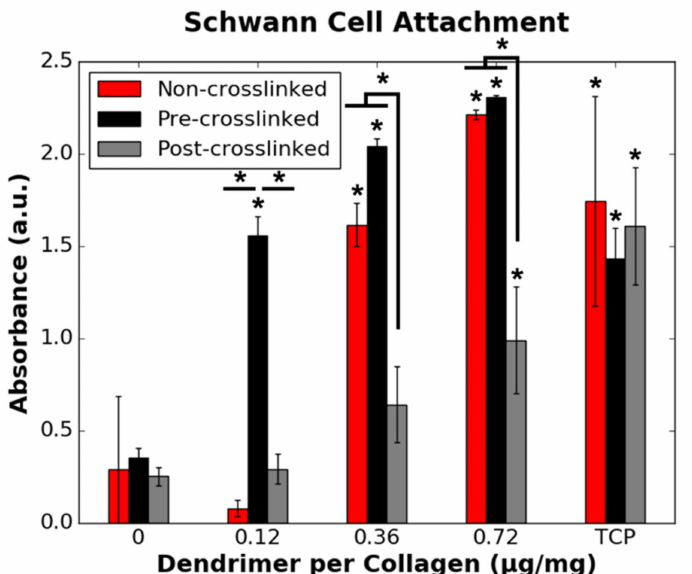
Figure 6. Effect of the quantity of IKVAV-capped dendrimers added to the various collagen films on RSC binding. RSCs were seeded onto non-collagen coated wells (TCP controls) on the same 48-well plates as each collagen substrate variety. * denotes statistically significant difference ( p ≤ 0.05) between the data point annotated and the respective 0 µ g/mg value for each collagen substrate, unless indicated